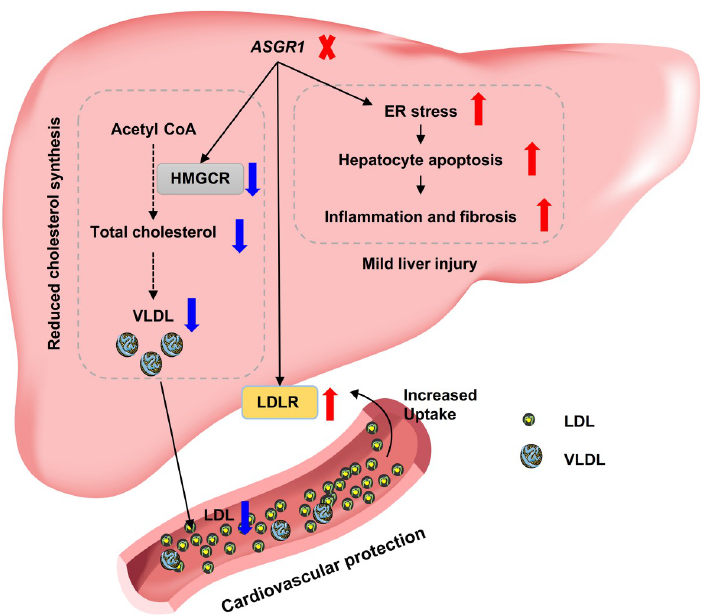
Fig 7. Graphical summary of the underlying mechanisms of ASGR1 deficiency-mediated atheroprotective effects and liver injury. Left , ASGR1 deficiency prevents atherosclerosis by downregulation of HMGCR-catalyzed hepatic cholesterol synthesis and its subsequent VLDL secretion, as well as by upregulation of LDLR-mediated hepatic LDL uptake. Right, the occurrence of liver injury shown by elevated hepatic enzymes, extensive apoptosis, mild inflammation and fibrosis due to ER stress-induced apoptosis upon ASGR1